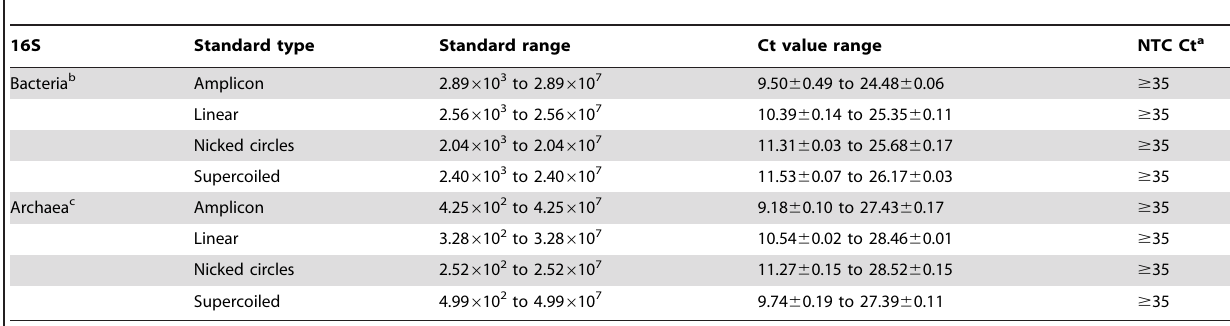
Figure 2. Circular and linear standard curves have similar slopes, y-intercepts, and amplification efficiencies. Linear regression between log 10 16S rRNA gene copies and Ct value based on ( a ) bacterial ( T. lienii ) and ( b ) archaeal ( A. fulgidus ) standards. Diamonds=supercoiled plasmid standard, squares=nicked-circular plasmid standard, triangles=linearized plasmid standard, and circles=PCR amplicon-based standard. Data are the average (n=3) and error bars are 6 1 standard deviation between replicates. Slopes and y-intercepts were not significantly different for bacterial (P=0.97) or archaeal (P=0.99) curves. doi:10.1371/journal.pone.0051931.g002 (Geneaid, Agoura Hills, CA, USA). Plasmid lengths were 5451 bp Preparation of 16S rRNA Gene Plasmid and Amplicon and 5317 bp for bacteria and archaea, respectively. Plasmid DNA DNA Standards concentrations were quantified as described above and used Circular plasmid (supercoiled and nicked-circles), linearized immediately. plasmid, and PCR amplicon standards were prepared for microbial 16S rRNA gene estimate comparisons. The pCR4- Table 2. Standard setup and Ct range for qPCR